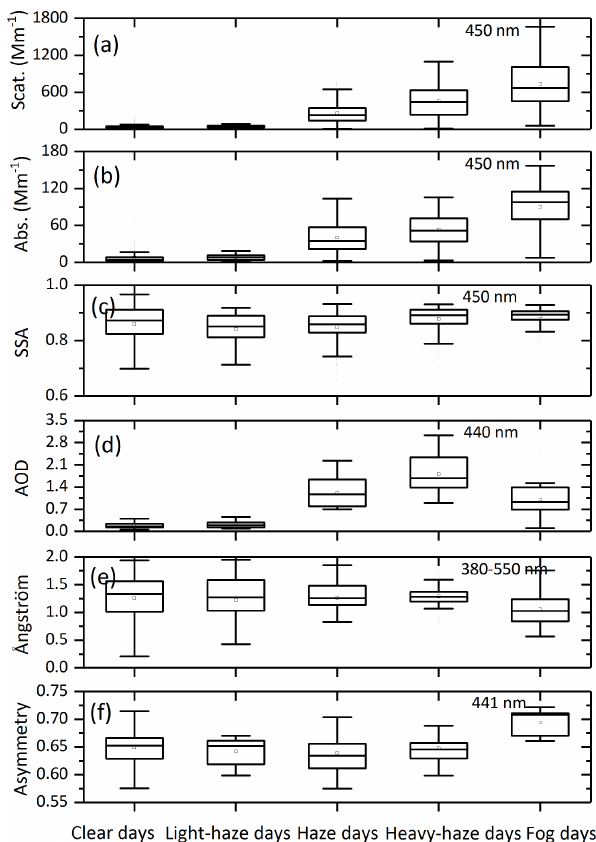
Figure 6. Box plots of the statistics on aerosol optical properties under different weather conditions: (a) σ sca , (b) σ abs , (c) SSA, (d) AOD, (e) Ångström exponent, and (f)